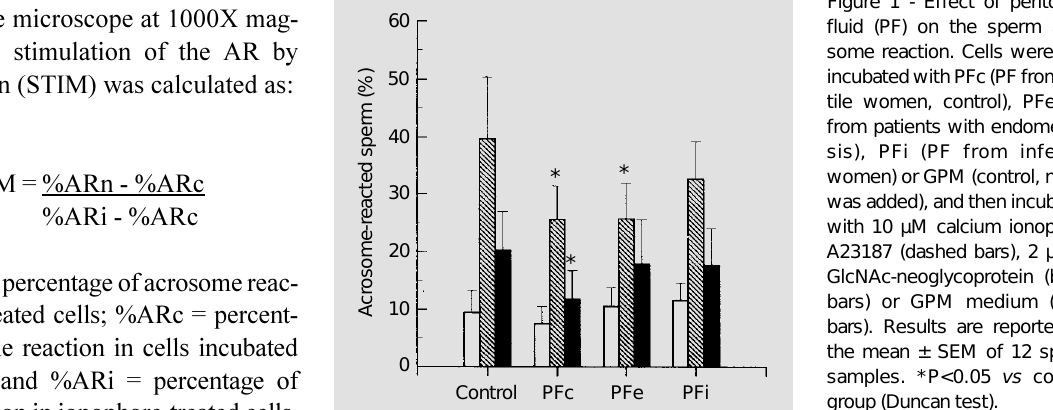
Figure 1 - Effect of peritoneal fluid (PF) on the sperm acro- some reaction. Cells were pre- incubated with PFc (PF from fer- tile women, control), PFe (PF from patients with